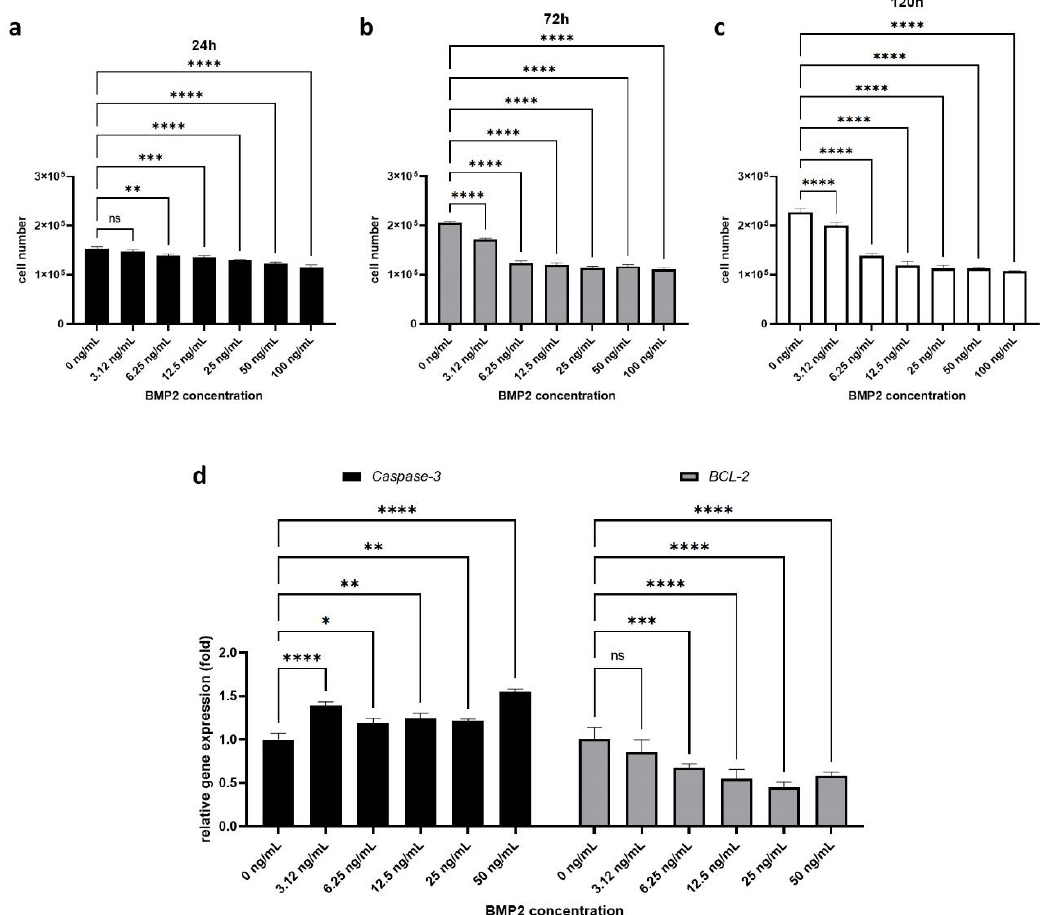
Figure 1. Effect of BMP-2 on H295R cell proliferation. The cell number after 24 h ( a ), 72 h ( b ), and 120 h ( c ) of treatment. ( d ) Relative expression of pro-apoptosis marker gene Caspase-3 expression, and anti-apoptosis gene BCL-2 expression. Data are presented as the mean ± SD. ( n = 3, significance level, * p < 0.05, ** p < 0.005, *** p < 0.0005, **** p < 0.0001; ns: Not